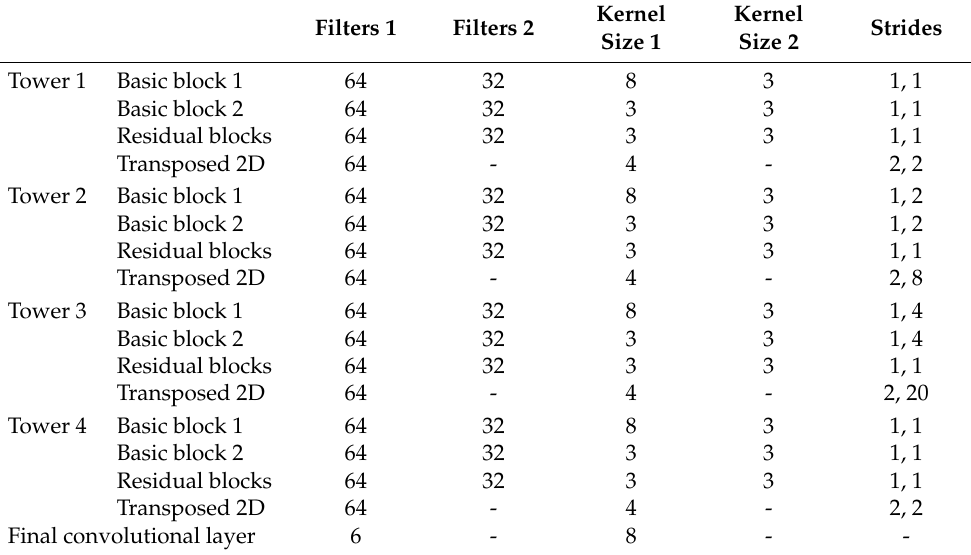
Figure 2. Network architecture for the normal and the modified tower network. The observational data have the dimensions 40 × 40 × 12, and the NWP data 40 × 40 × 6. The specific parameters used in this work are listed in Table 1. Table 1. All network parameters for the tower networks in the first part of the work. Kernel Filters 1 Filters 2 Size